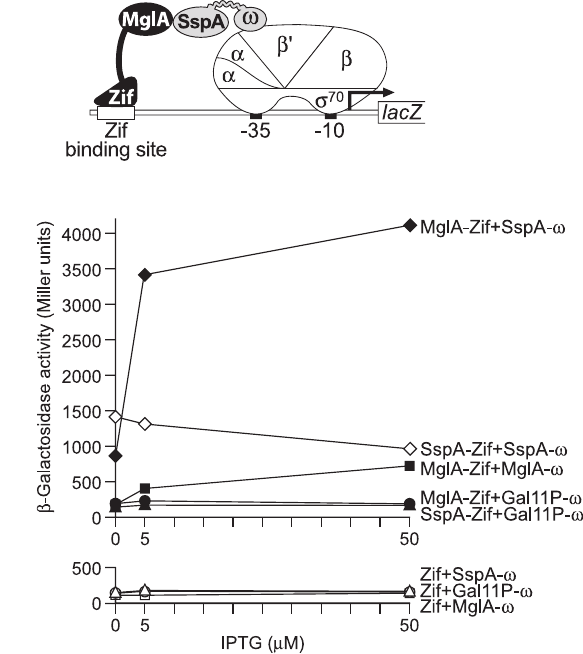
Figure 2. Bacterial Two-Hybrid Analysis of Protein–Protein Interactions Involving MglA and SspA (A) Schematic representation of the two-hybrid system. Contact between MglA and SspA fused, respectively, to Zif and to the x subunit of E. coli RNAP activates transcription from the test promoter, driving expression of lacZ . The diagram depicts test promoter p lac Zif1–61, which bears a Zif binding site centered 61 bp upstream of the transcription start site of the lac core promoter (whose (cid:2) 10 and (cid:2) 35 elements are indicated). In E. coli strain KDZif1 D Z, this test promoter is linked to lacZ on an F 9 episome. (B) Transcription activation by MglA-Zif in the presence of the SspA- x or MglA- x fusion proteins, and by SspA-Zif in the presence of the SspA- x fusion protein. KDZif1 D Z cells harboring compatible plasmids directing the synthesis of the indicated proteins were grown in the presence of different concentrations of IPTG and assayed for b -galactosidase activity.